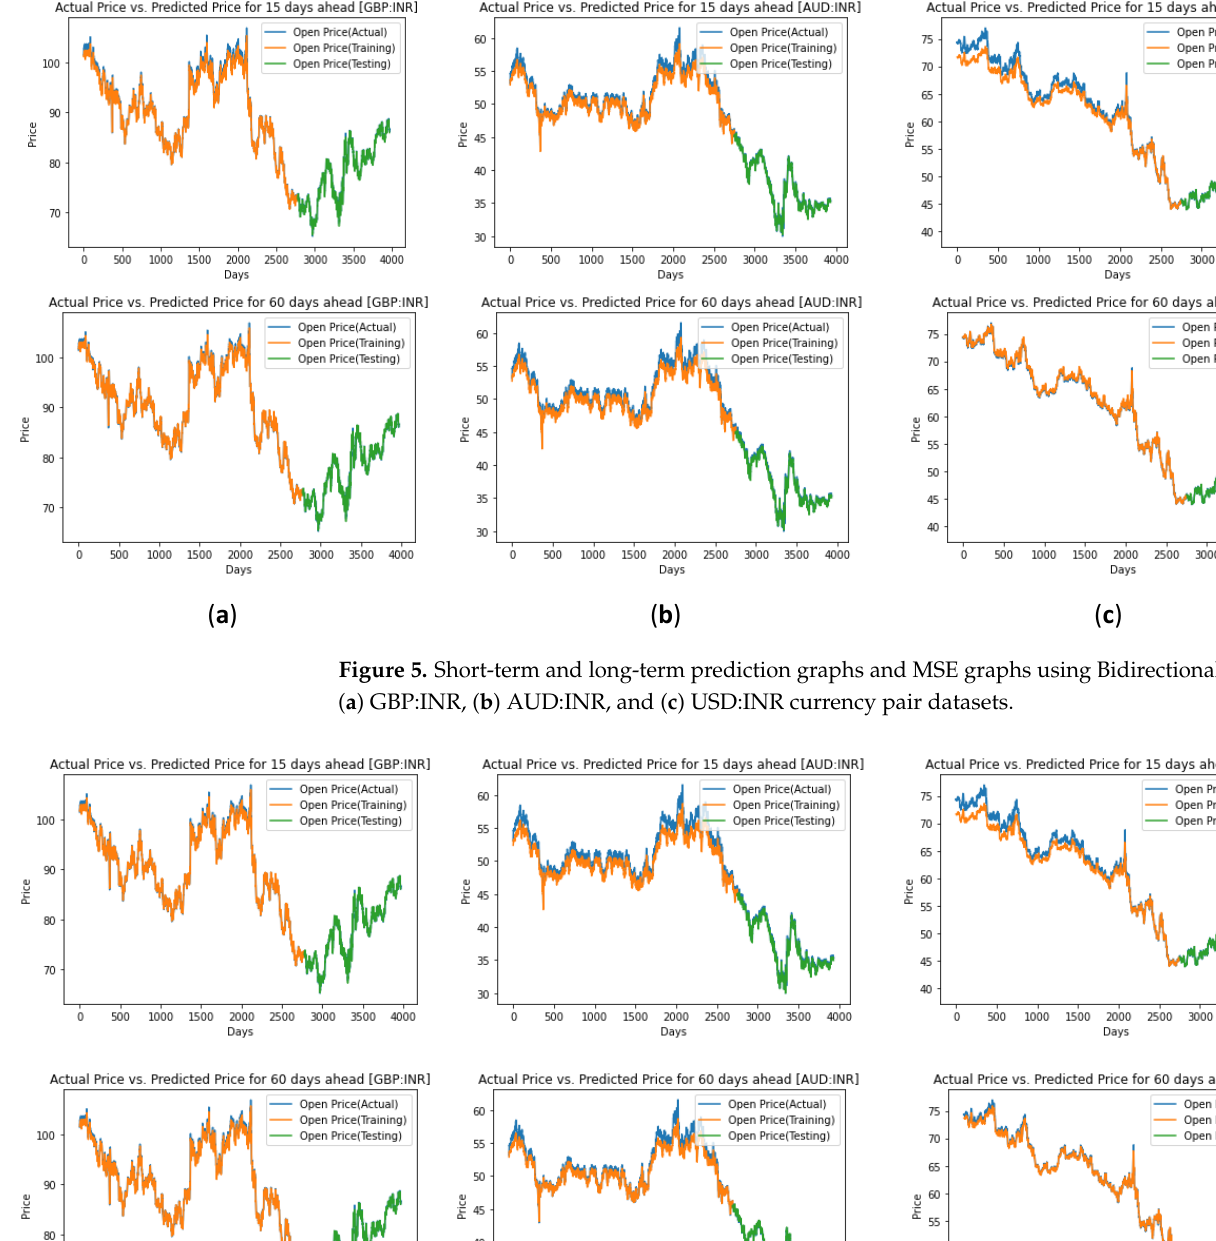
Figure 4. Short-term and long-term prediction graphs and MSE graphs using Stacked-LSTM for ( a )